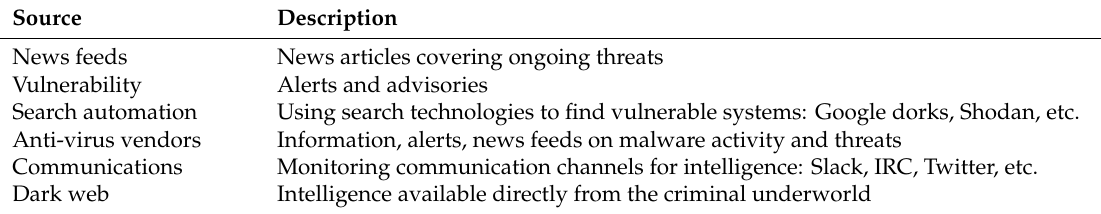
Table 3. Externally sourced